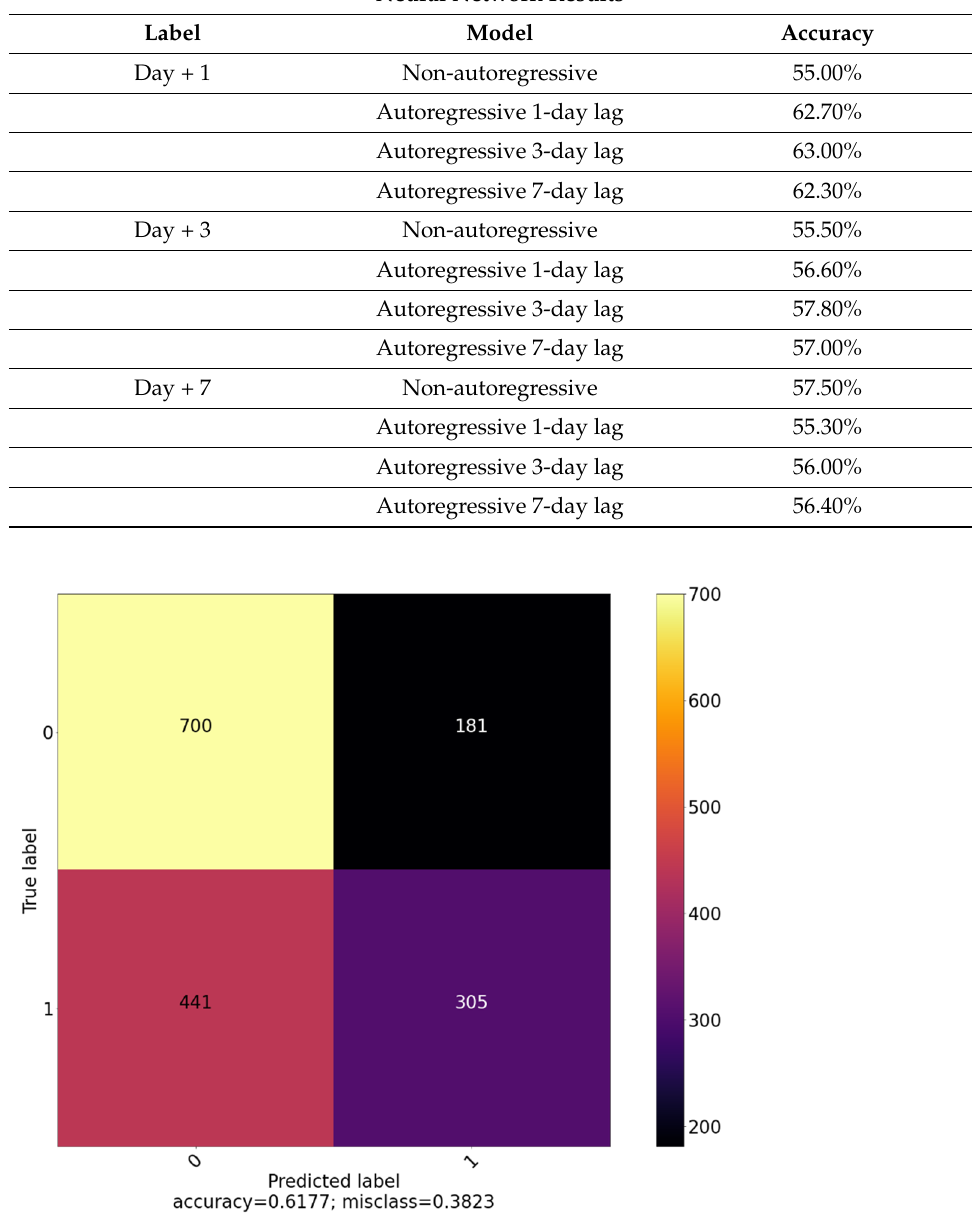
Table 4. Results from Neural Network models.